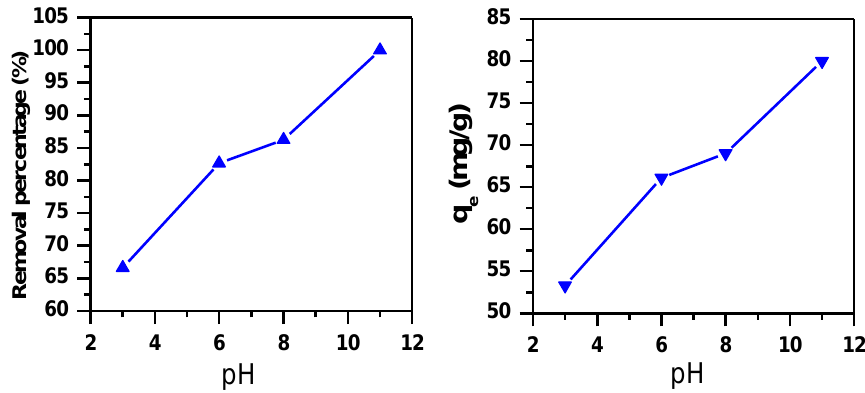
g, contact time = 30 min).